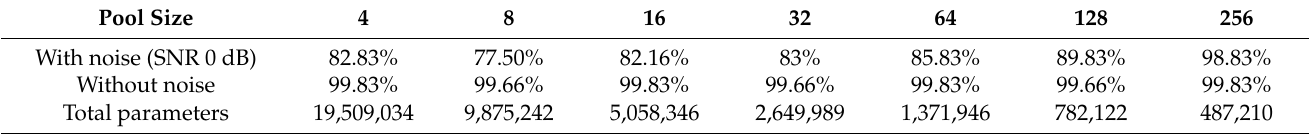
Table 7. The effect of pool size on the performance of the proposed model in noisy